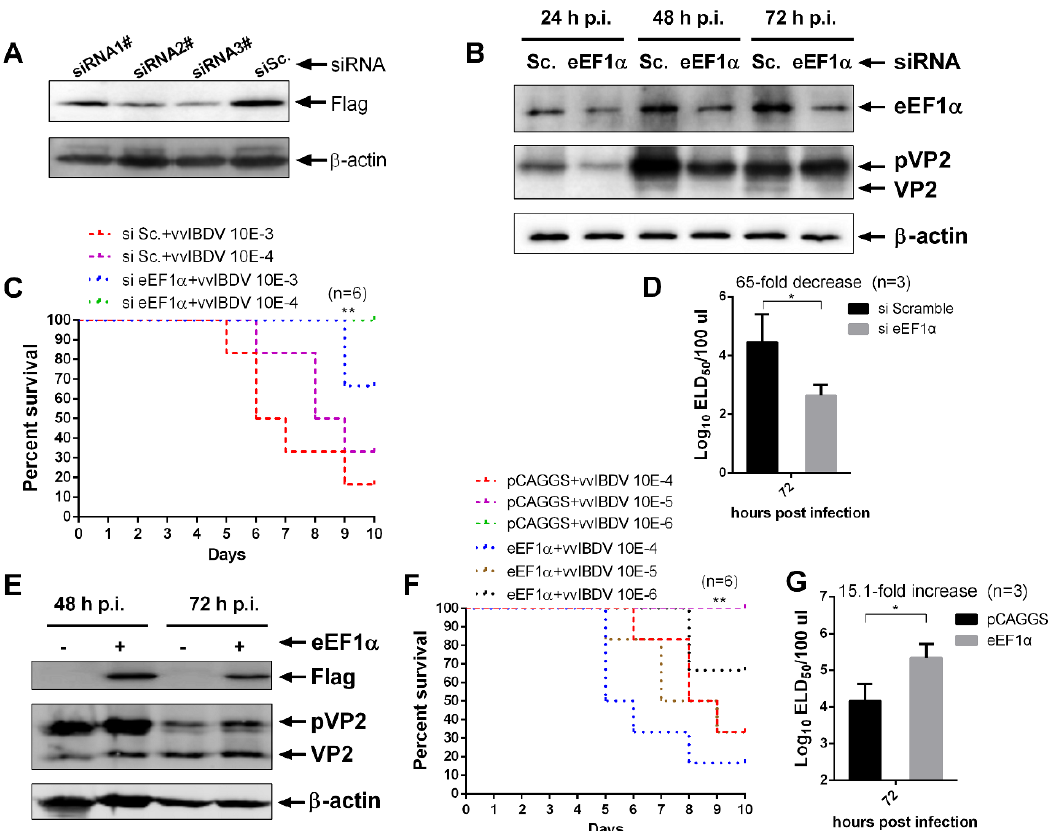
Figure 2. Chicken eukaryotic translation elongation factor 1 α (cheEF1 α ) promoted the replication of vvIBDV. ( A ) E ff ects of siRNAs on the cheEF1 α expression. 293T cells were transfected with Flag-tagged cheEF1 α accompanied with siRNAs (RNAi#1, RNAi#2, or RNAi#3) or scrambled siRNA. Cell lysates were harvested 48 h after transfection and tested by Western blotting with anti-Flag antibody. Endogenous β -actin expression was used as an internal control. ( B ) Yields of viral proteins in cheEF1 α knockdown cells. Viral proteins loads were analyzed by Western blotting at 24 h, 48 h, and 72 h post-infection (p.i.) with vvIBDV Gx at multiplicity of infection (MOI) = 1 compared the potent cheEF1 α siRNA treatment to scrambled siRNA treatment. The amount of cheEF1 α indicated the e ffi ciency of siRNA silencing and β -actin was used as the loading control. ( C ) Typical survival curve of chicken embryos infected with extracellular progeny virus in cheEF1 α knockdown cells. Progeny viruses in extracellular of cells with or without cheEF1 α knockdown were harvested at 72 h p.i., and chicken embryos were infected with 10-fold diluted progeny viruses, with the number of deaths for 9 days post-infection being recorded. One of three independent tests was shown as survival curve, and these three independent tests of 50% embryo lethal dose (ELD 50 ) were summarized in ( D ). ( E ) Yields of viral proteins in cheEF1 α over-expression cells. Viral protein loads were analyzed by Western blotting at 48 h and 72 h p.i. with vvIBDV Gx at MOI = 1 with or without cheEF1 α over-expression. ( F ) Typical survival curve of chicken embryos infected with extracellular progeny virus in cheEF1 α over-expression cells. The progeny virus titers based on 50% embryo lethal dose (ELD 50 ) are summarized in ( G ). Error bars and mean ± SD were calculated on the basis of three independent experiments. The statistical analysis of survival curve was analyzed with GraphPad Prism 6 software, and the other statistical analysis was performed with t -tests considered significant with one asterisk as p < 0.05 and two asterisks as p <